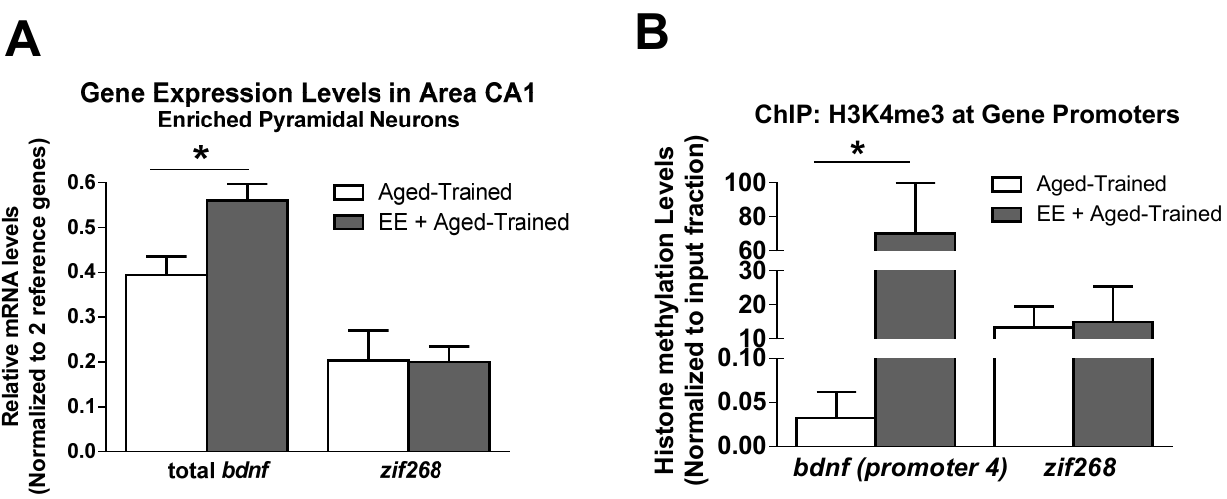
Figure 7. Environmental enrichment elevates H3K4me3 methylation levels at the Bdnf gene in the aged hippocampus. ( A ) Object Learning increases Bdnf mRNA level in the hippocampus of EE aged adults ( n = 4) relative to non-enriched aged adults ( n = 5); ( B ) ChIP analysis revealed EE dependent increases in H3K4me3 levels at the Bdnf promoter 4 during memory formation; Group sizes for ( B ): Aged-Trained, n = 4; EE + Aged-trained, n = 3. Student’s t-test ; * p < 0.05 compared to non-enriched aged-trained adults. Data are shown ±